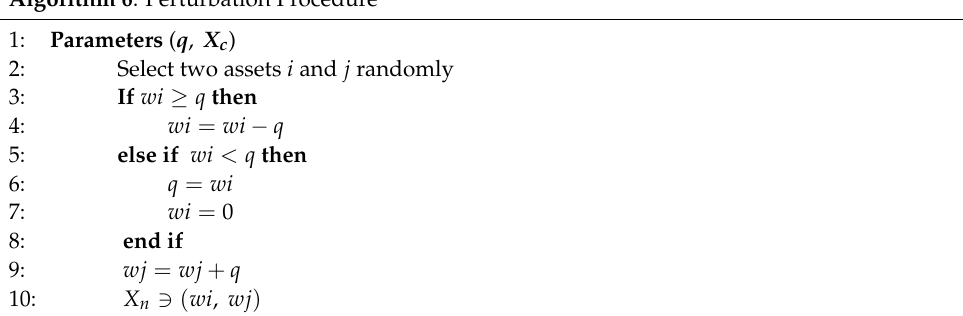
Algorithm 6 . Perturbation